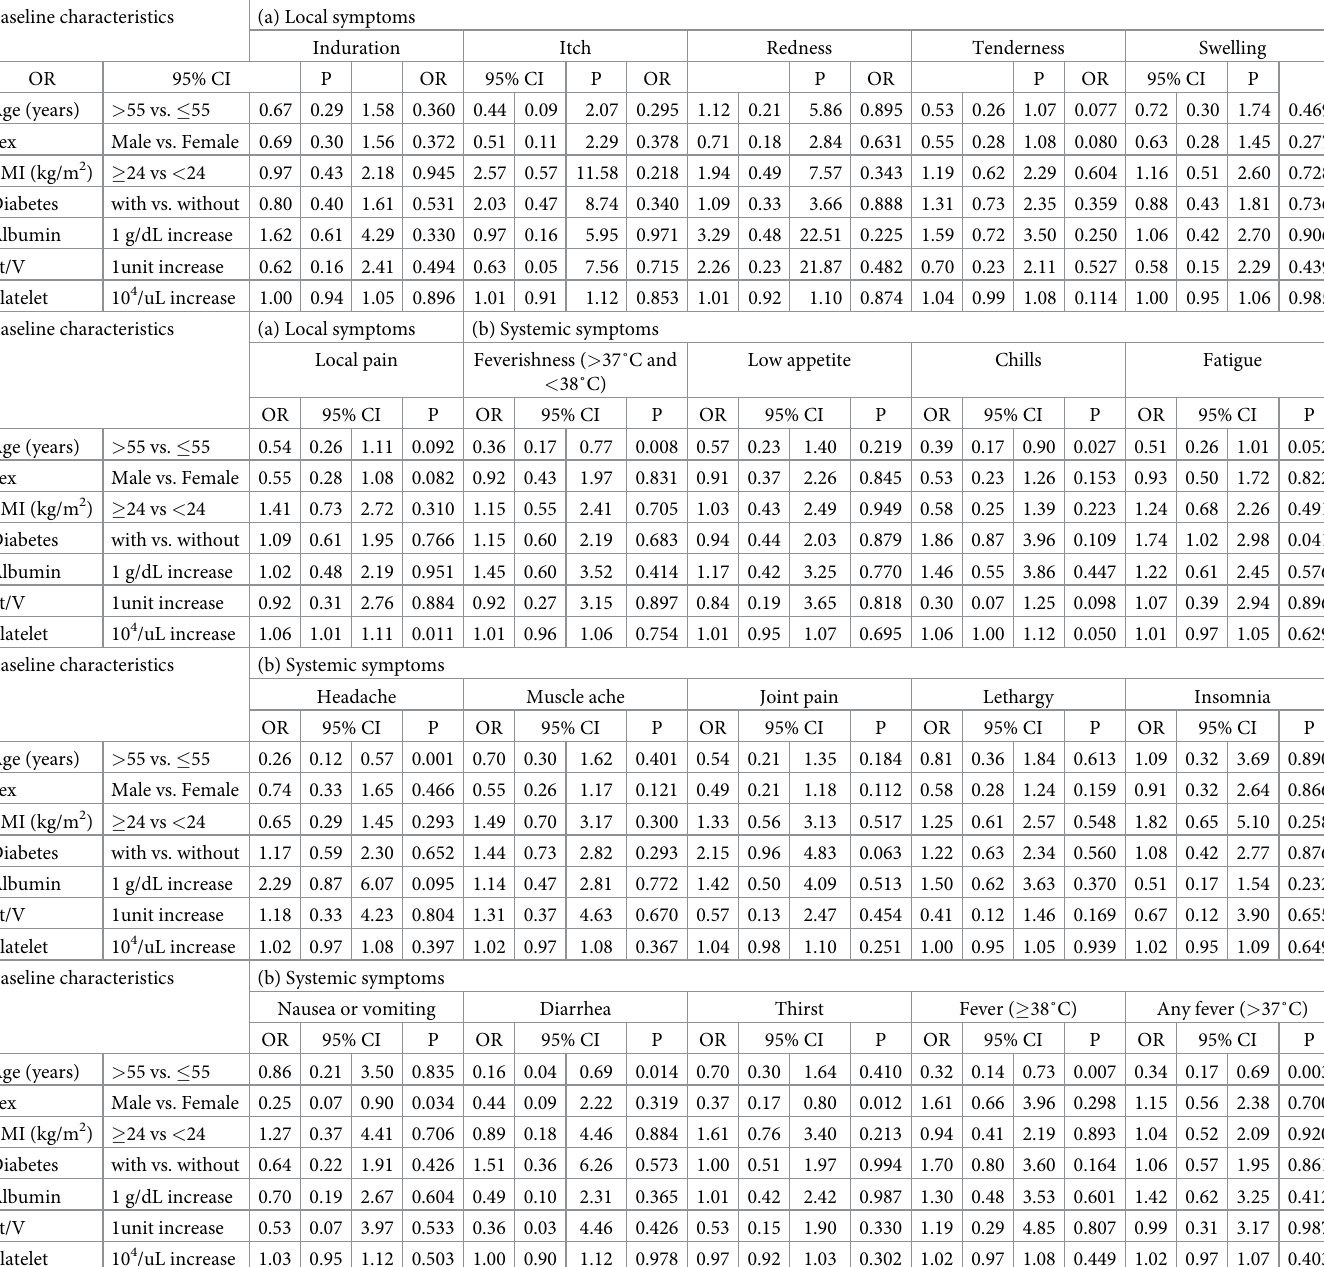
Table 2. Multivariable logistic regression analyses for risk factors of local (2a) and specific systemic (2b) adverse effects on day 2 of ChAdOx1 nCoV-19 (Oxford- AstraZeneca) vaccination (first dose) in ESRD patients. Baseline